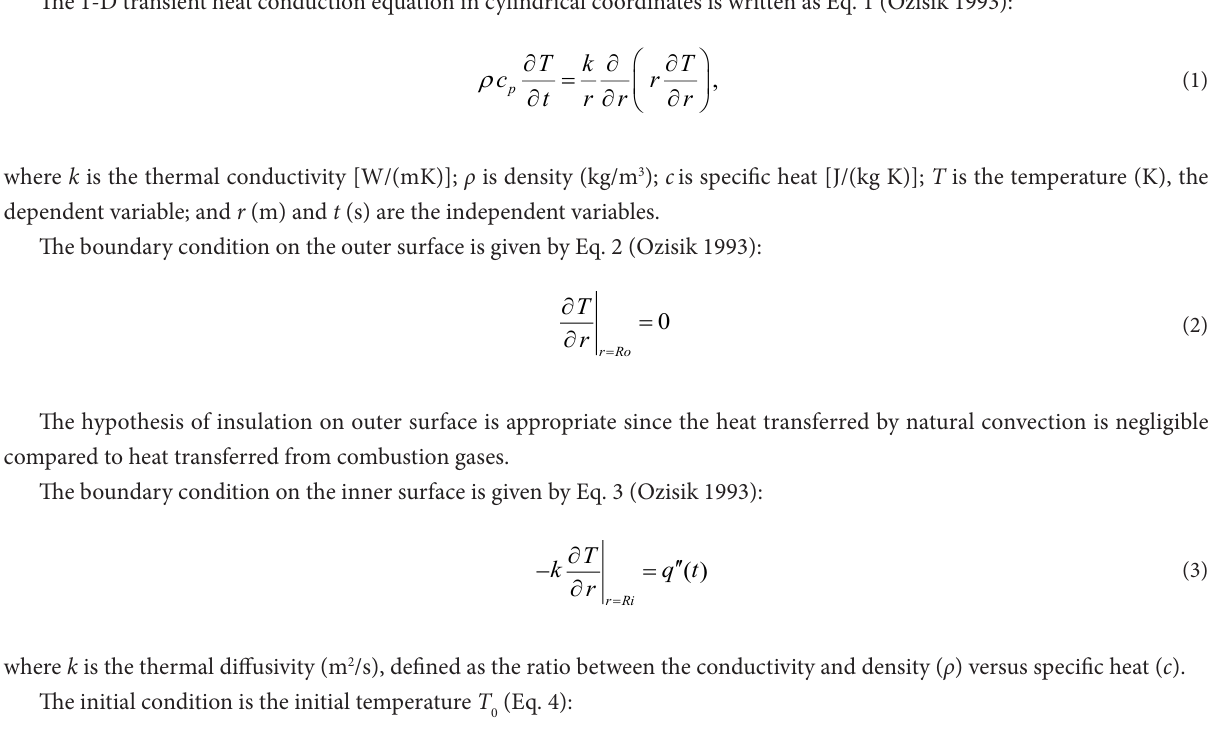
Figure 1. Geometry of the problem.